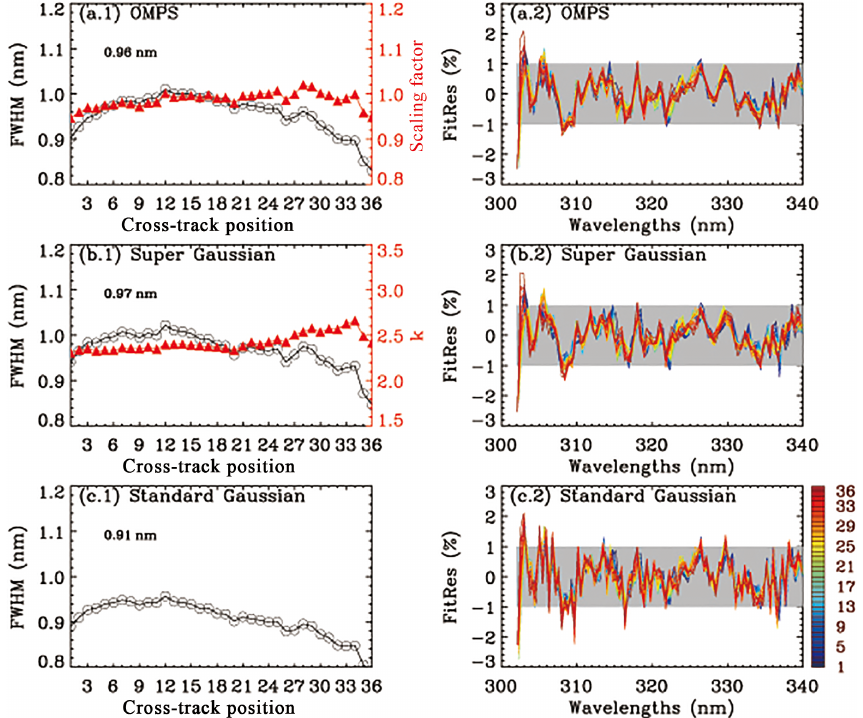
Figure 2. (a1, b1, c1) Slit function parameters as a function of cross-track position (1th–36th) for three different slit functions from OMPS irradiance measurements (302–340nm) for orbit 7132 on 14 March 2013. The legends represent the FWHM averaged over all spectral pixels. (a2, b2, c2) The corresponding relative fitting residuals between measured and simulated irradiance spectra.